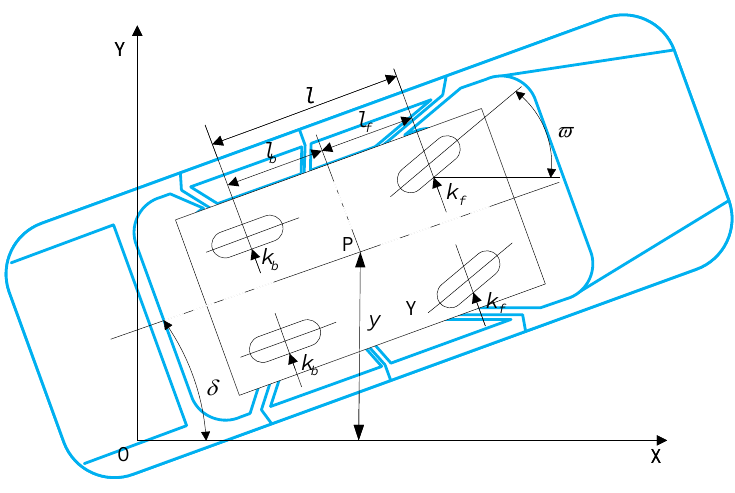
Figure 2. Schematic diagram of the Vehicle Kinematic